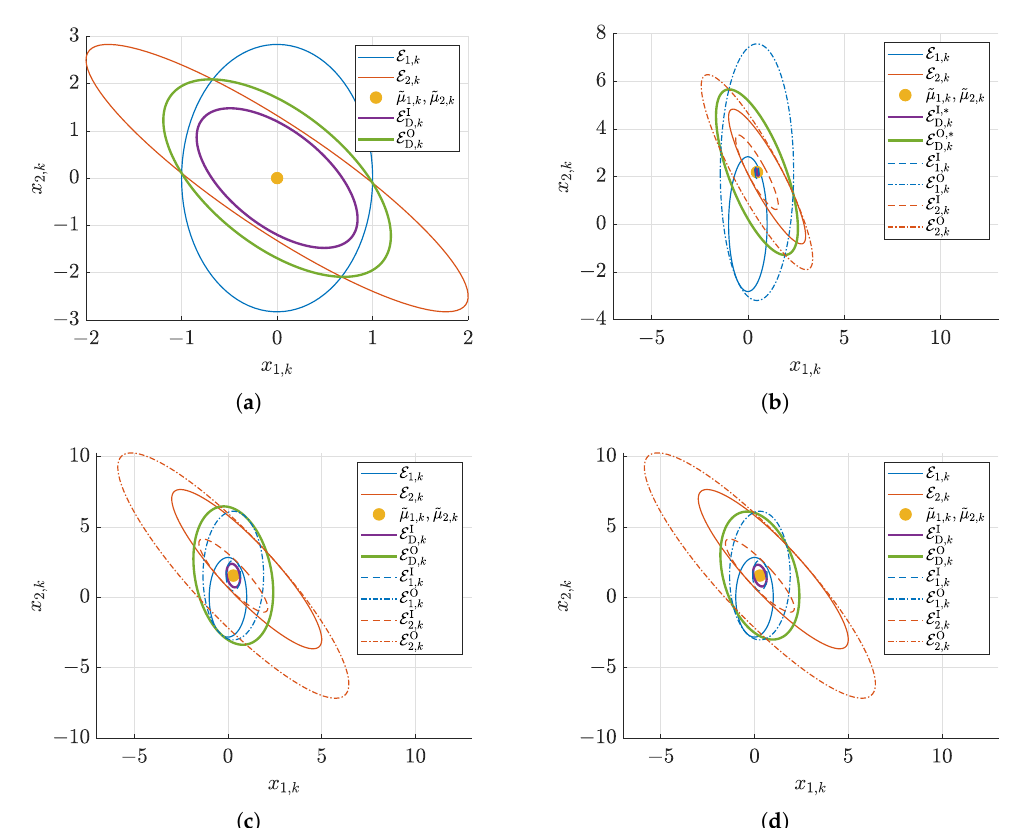
Figure 3. Intersection of ellipsoids E 1, k and E 2, k with identical and different midpoints. Inner bound of the resulting thick ellipsoid: E I ; outer bound: E O ( ∗ symbols denote the solution enclosure D, k D, k according to Equation (53)). ( a ) Case according to Section 3.2.1 with the shape matrices (55). ( b ) Case according to Section 3.2.2 with the initial ellipsoid parameterization (55), (56), enclosure definition (53). ( c ) Case according to Section 3.2.2 with the initial ellipsoid parameterization (56), (57), enclosure definition (49). ( d ) Case according to Section 3.2.2 with the initial ellipsoid parameterization (56), (57), enclosure definition